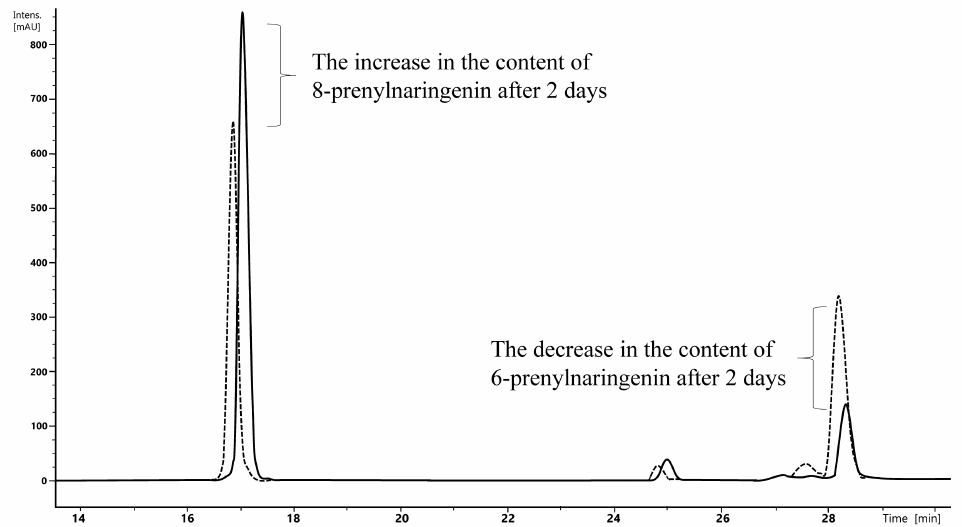
Figure 4. Chromatogram showing changes in levels of 8-prenylnaringenin and 6-prenylnaringenin, measured at λ = 290 nm in standard solutions over a 2-day